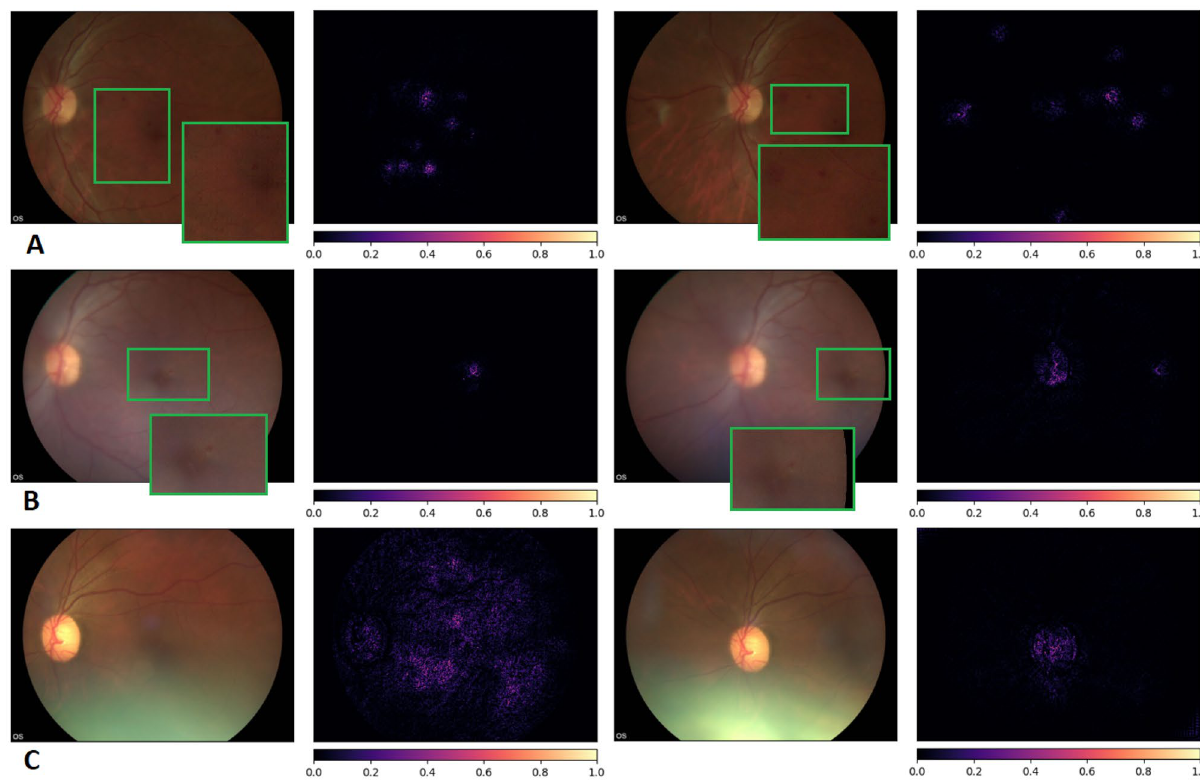
Figure 4. Integrated gradients pixel attributions. Pairs of macula and optic disc centred images of three different patient eyes and the obtained saliency maps ( A ) Severe NPDR, referable DME, DLS score 0.98. ( B ) Moderate NPDR, No DME, DLS score 0.58, ( C ) No DR, No DME, 0.04. The saliency maps highlight relevant lesions for the diagnosis (microaneurysms). In the absence of referable DR/DME, only the optic disc or general regions of the retina are